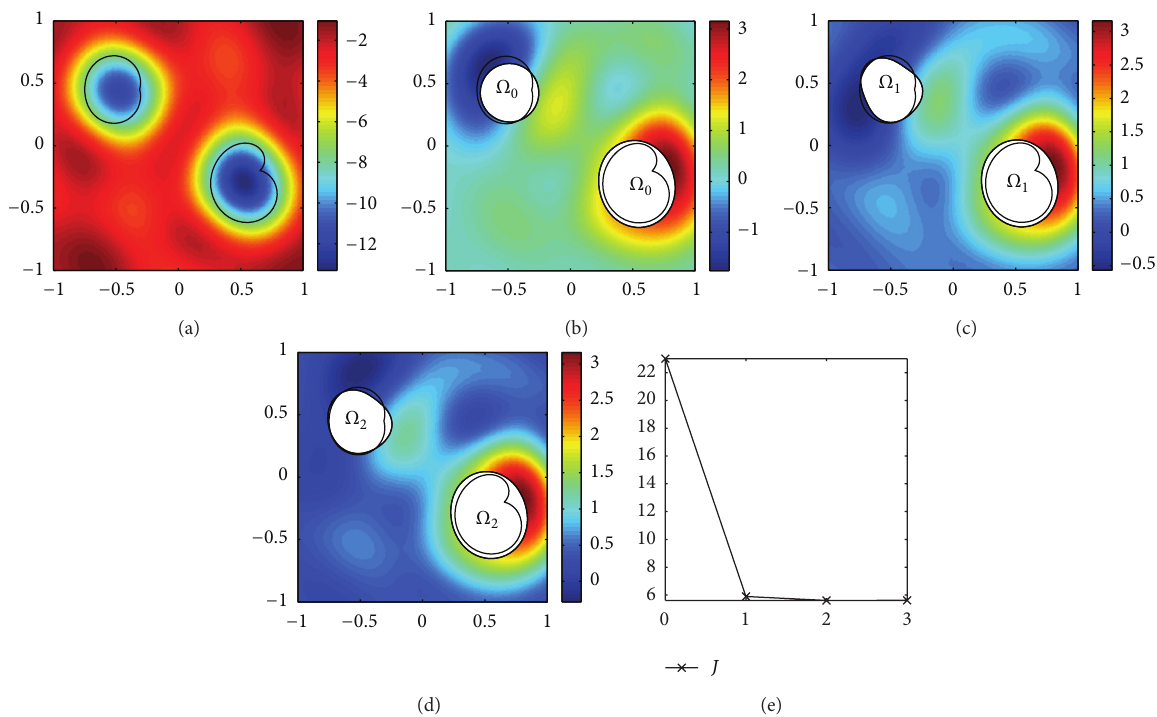
Figure 5: Reconstruction of objects when 𝑘 𝑖 = 1 is known, with the monotone algorithm (18). (a) Topological derivative when Ω = 0 . (b)–(d) Approximate domains Ω 𝑚 superimposed to the topological derivative for Ω = Ω 𝑚 . (e) Evolution of the cost